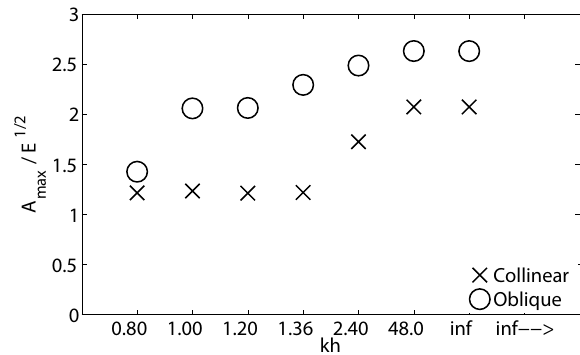
Fig. 4. Maximum wave amplification as a function of the relative water depth for k 0 a 0 = 0 . 1, M = 5.